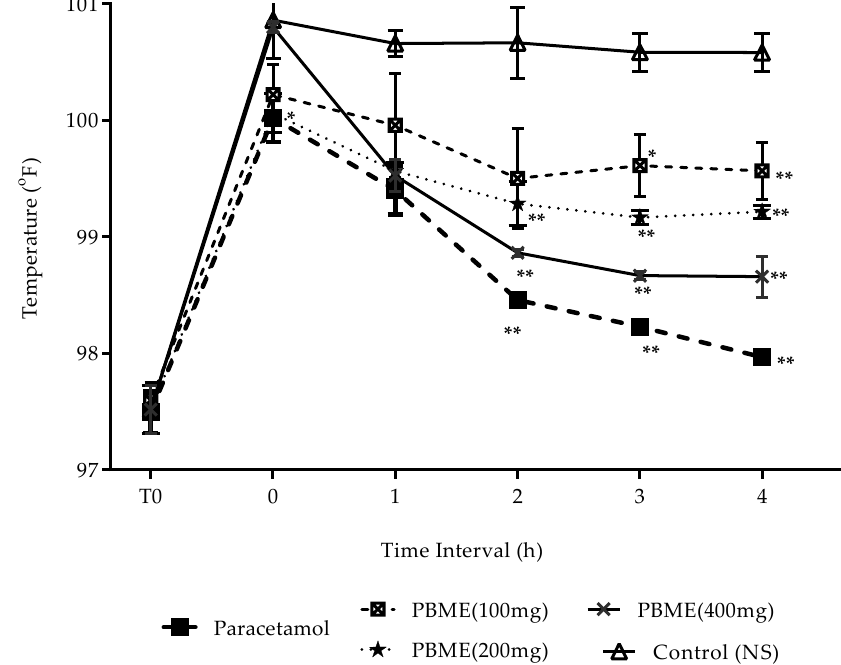
Figure 1. Antipyretic activity effect of P. benghalensis leaves’ methanol extract (PBME) and paracetamol in Brewer's yeast induced hyperthermia rats. Values are mean ± SD ( n = 6). p -value measured by ANOVA followed with Dunnett’s post hoc multiple comparisons. * p < 0.01, and ** p < 0.001 compared to control.